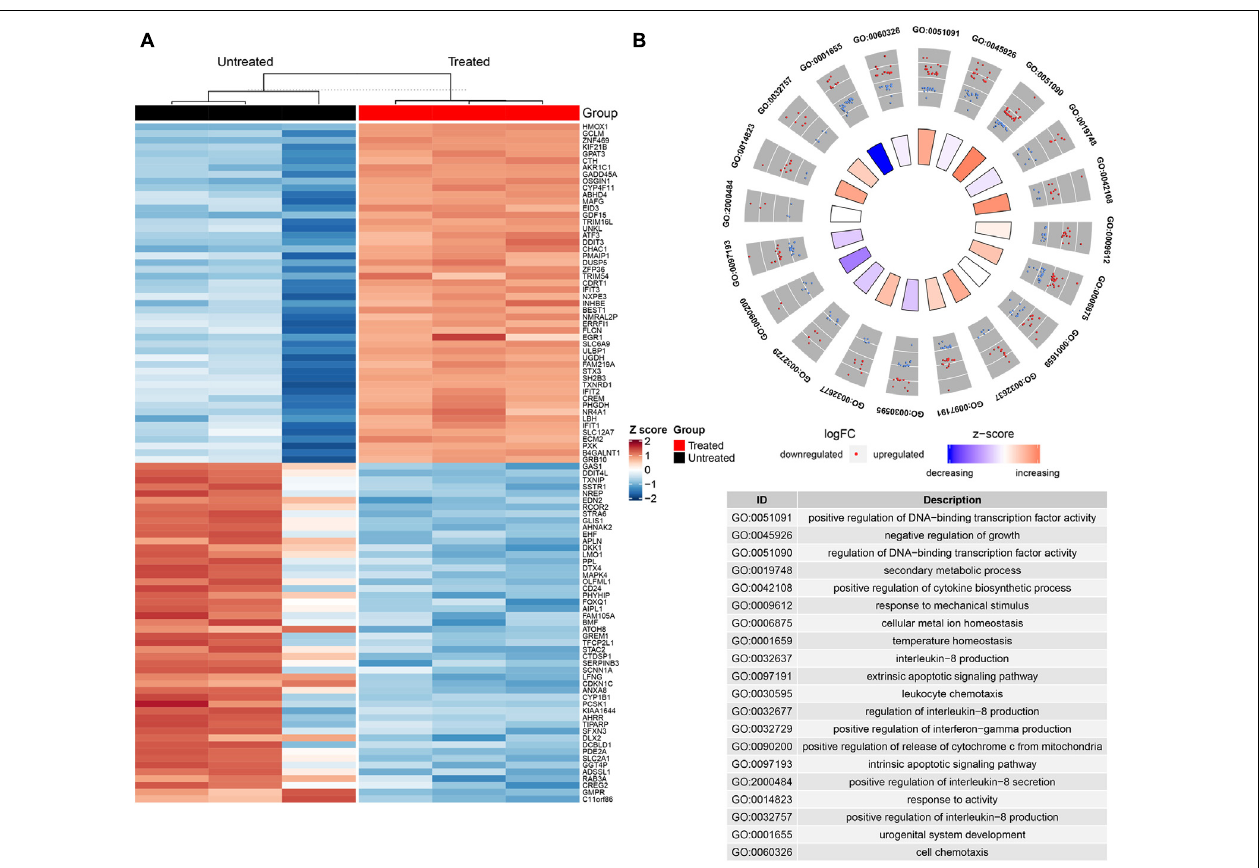
FIGURE 2 | Transcriptome alterations of H446 cancer cells were uncovered by high-throughput sequencing. (A) The hierarchical clustering heatmap showed the significant differentiation of gene expression in H446 cells treated with or without curcumin ( n = 3). The top 50 differentially expressed genes are provided on the right. Each column represented a tested sample and each row represented a given gene. The brightness of the color reflected the average expression level of certain gene, which had been standardized by z -score. The red indicated relatively higher gene expression while the blue represented lower gene expression. (B) GOPLOT of genes expressed differently ( p < 0.05) in H446 cells treated with or without curcumin ( n = 3) in biological process category. The red and blue spots in the scatter plot of out wheel showed upregulated and downregulated genes, respectively, while the inner wheel indicated the z